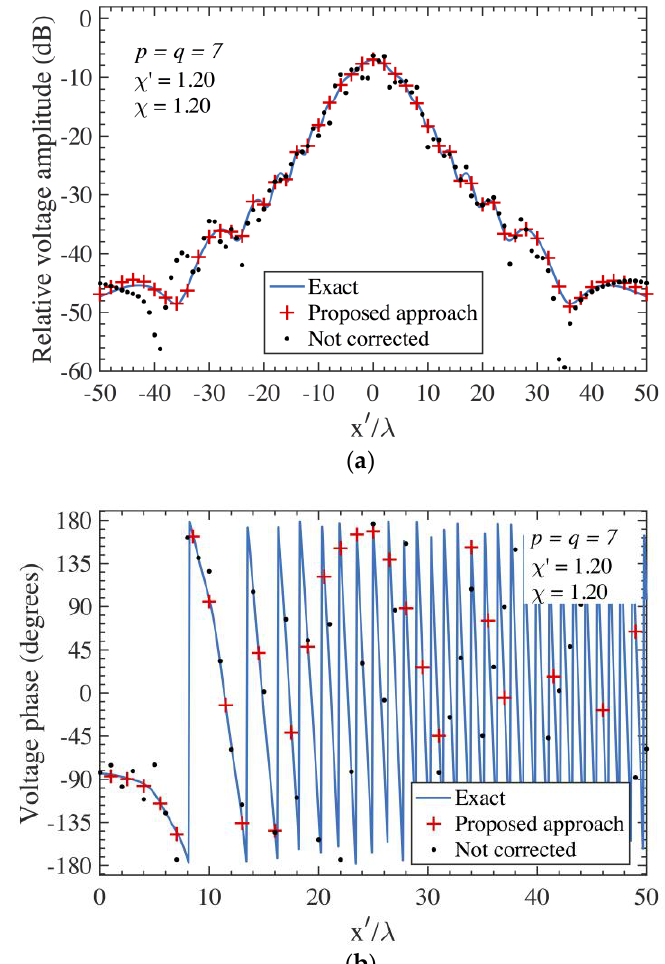
Figure 5. V y on the scanning plane at y ' = 15 λ − AUT 1. Blue line: exact. Red crosses: obtained from the positioning errors corrupted PWMS samples by using the devised multi-steps procedure. Black dots: obtained from the positioning errors corrupted PWMS samples without using the devised procedure. ( a ) Amplitude. ( b ) Phase.